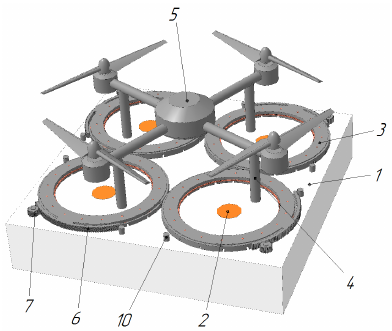
Figure 19. UAV landing platform with iris diaphragms for positioning [60] by Innopolis University. 1, landing surface; 2, electrical contacts on the landing surface; 3, iris diaphragm; 4, UAV legs; 5,